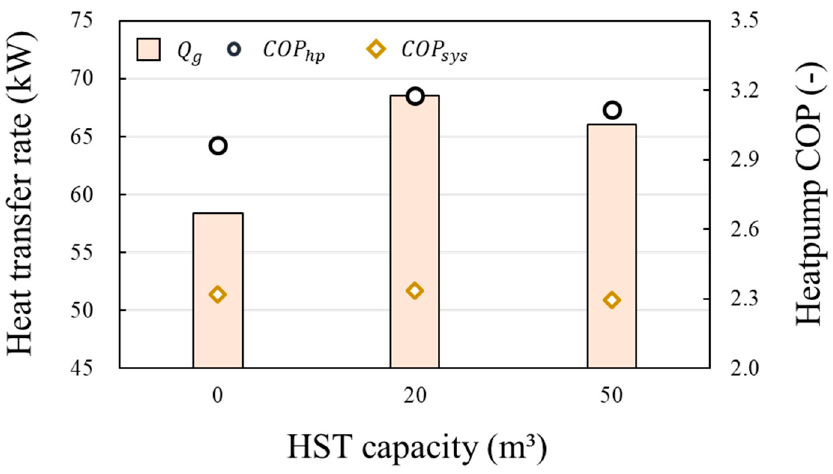
Figure 13. Average values of the heat pump COP and heat transfer rate according to the capacity of HST.